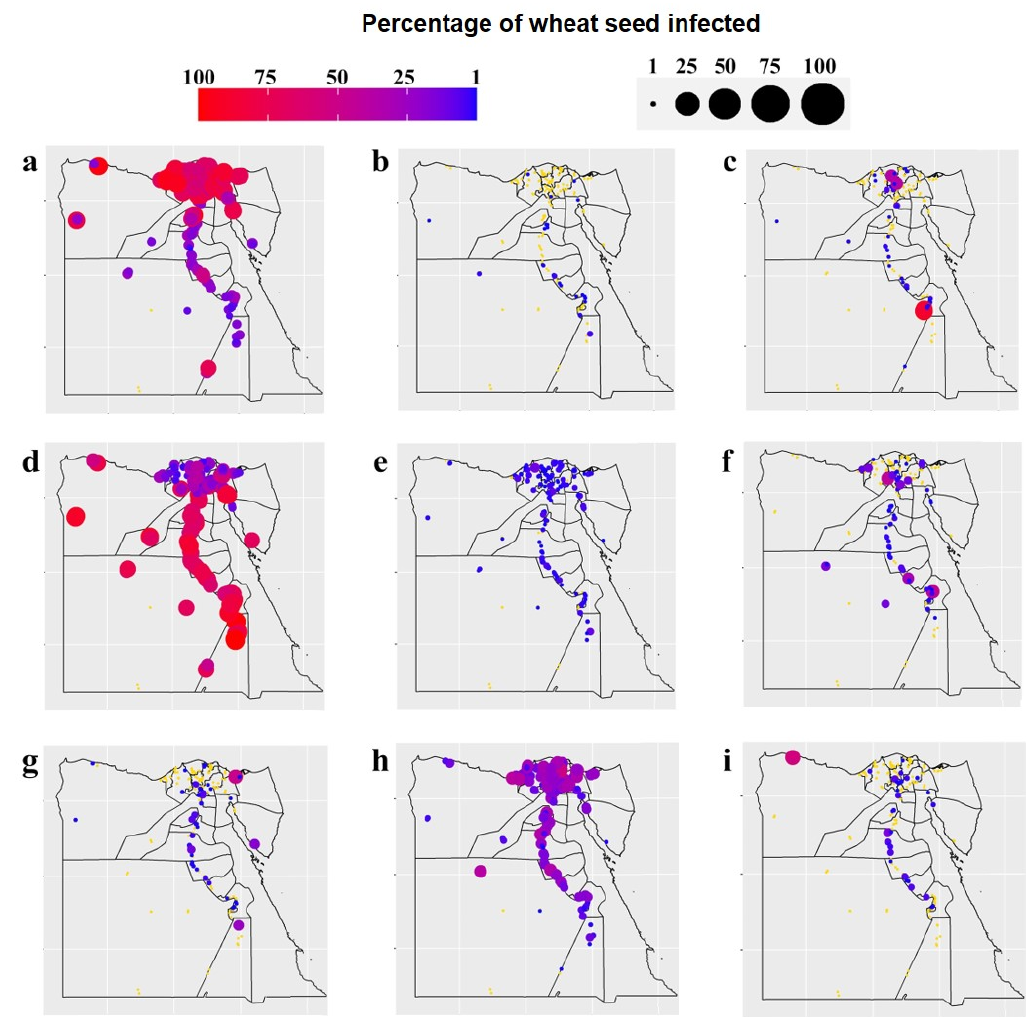
Figure 4. Geographical distribution and incidence (%) of important wheat seed-borne fungi in grain samples from each of the 25 wheat-growing governorates in Egypt: ( a ) Alternaria alternata , ( b ) Bipolaris sorokiniana, ( c ) Cephalosporium acremonium, ( d ) Cladosporium spp. ( e ) Epicoccum purpurascens , ( f ) Fusarium verticillioides , ( g ) Penicillium spp., ( h ) Stemphylium sp., and ( i ) Trichothecium roseum (circles in yellow mean no occurrence of the pathogen).